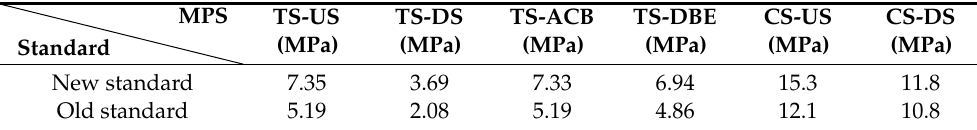
Table 3. The maximum tensile and compressive principal